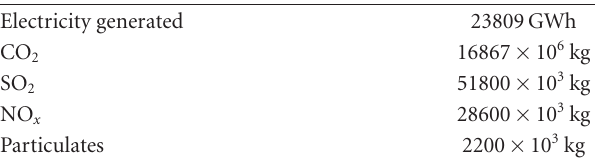
Table 2: Electricity generation and gas emissions produced by China Light and Power Company, Hong Kong, in 2004.